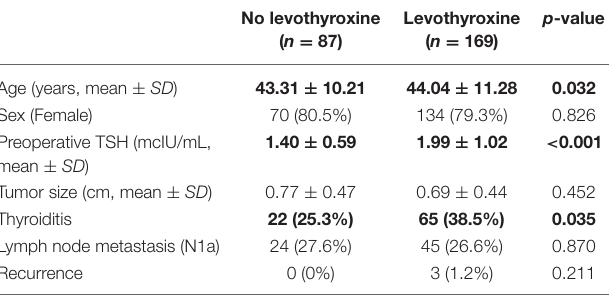
TABLE 2 | Clinicopathological characteristics according to levothyroxine